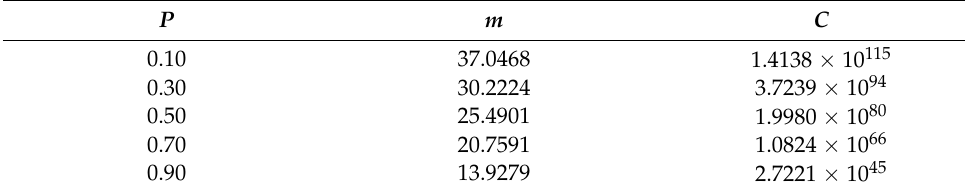
Table 2. P - S - N parameters of Ti-6246